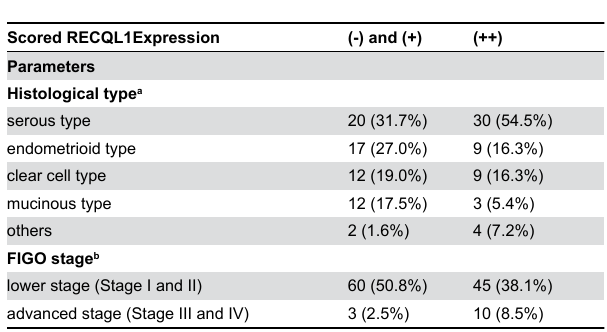
FIGO stage b lower stage (Stage I and II) 60 (50.8%) 45 (38.1%) advanced stage (Stage III and IV)